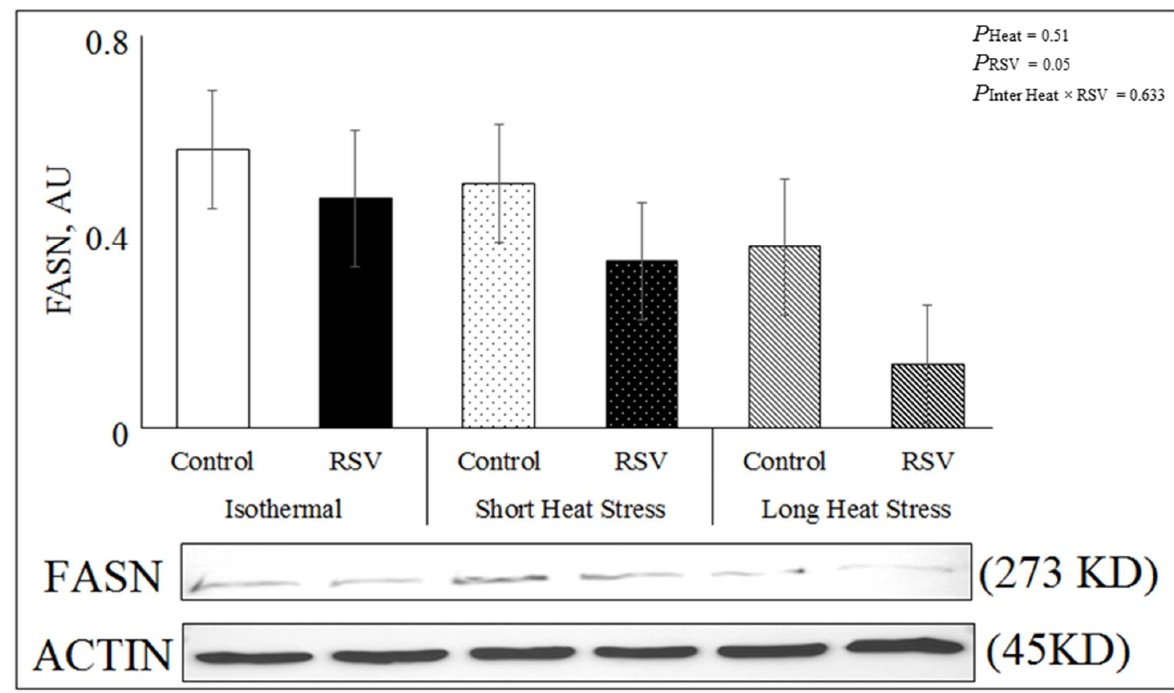
Figure 6. Effect of RSV (100 µ M for 48 h) on the abundance of FASN under isothermal (ISO; 37 ◦ C for 48 h), short heat stress (SH; 37 ◦ C for 47 h and 41.2 ◦ C for last 1 h), or long heat stress (LH; 37 ◦ C for 32 h followed by last 16 h at 41.2 ◦ C). Actin used as reference band.